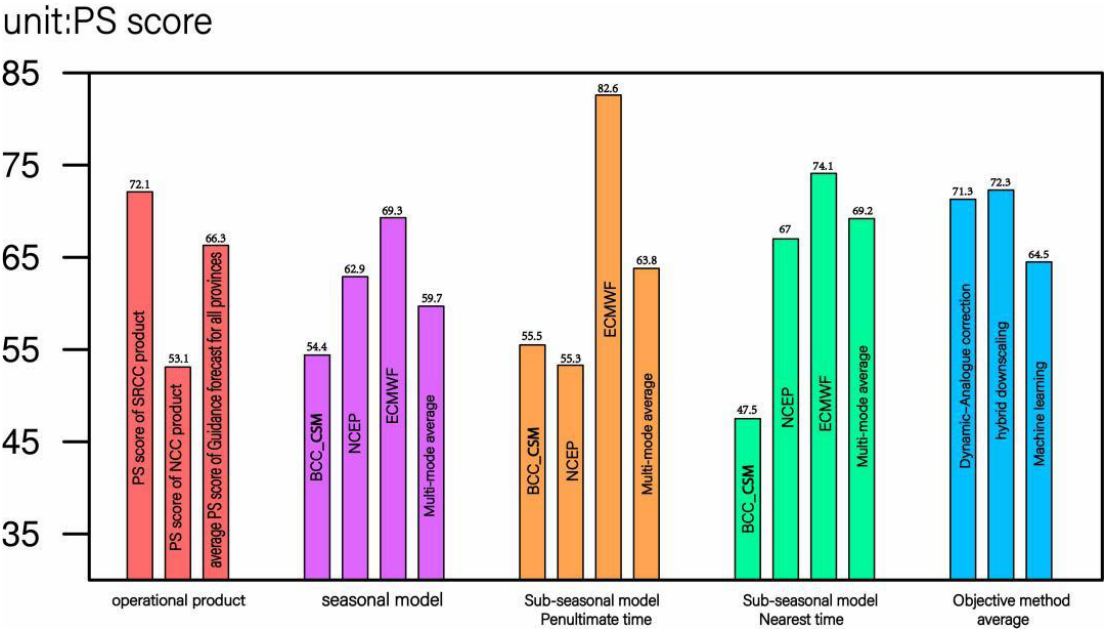
Figure 3. PS scores of June precipitation forecasts from different schemes.